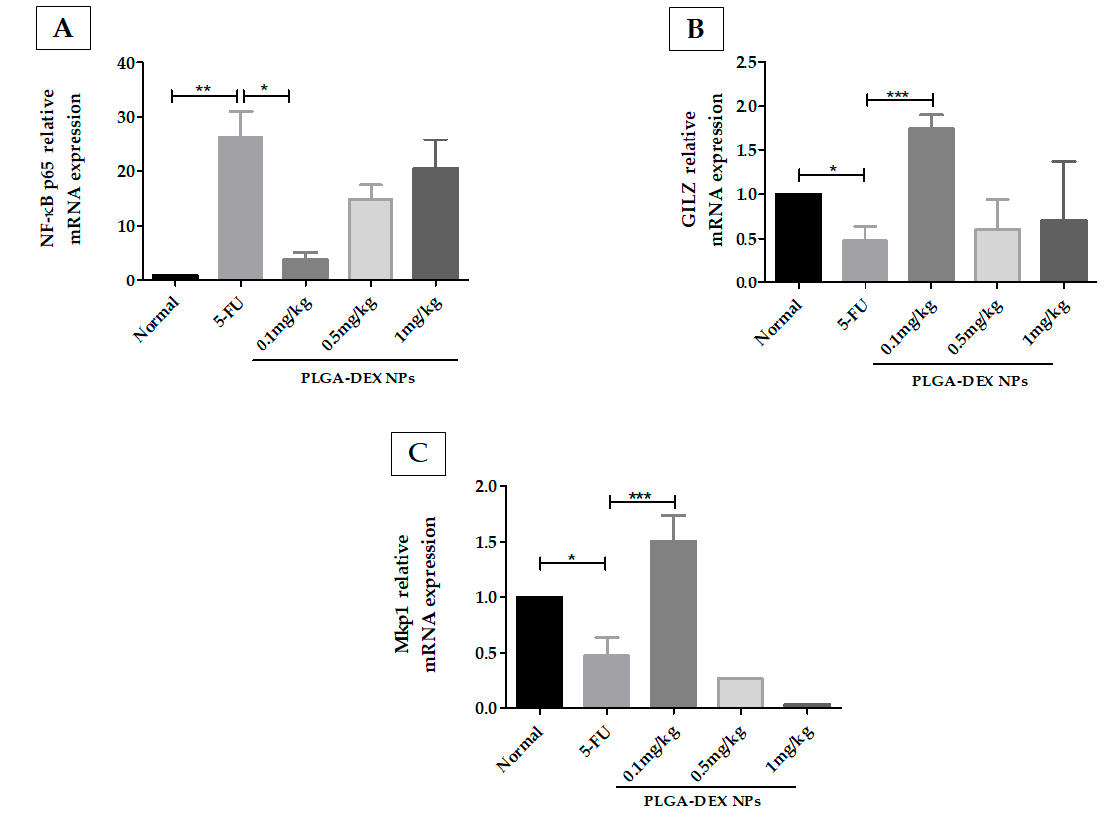
Figure 6. ( A ) q-RT PCR for NF-kB p65, ( B ) glucocorticoid-induced leucine zipper (GILZ), ( C ) MAPK phosphatase 1 (MKP1). 5-FU increased the expression of the NF- κ B p65 genes and decreased the gene expression of GILZ and MKP1, compared to the normal group. The animals in the PLGA-DEX group 0.1 mg/kg showed increased GILZ and MKP1 gene expression as well as reduced expression of the NF- κ B p65 gene, compared to the 5-FU group ( n = 5; * p < 0.05, ** p < 0.01, *** p < 0.001) (ANOVA followed by Tukey’s posttest).